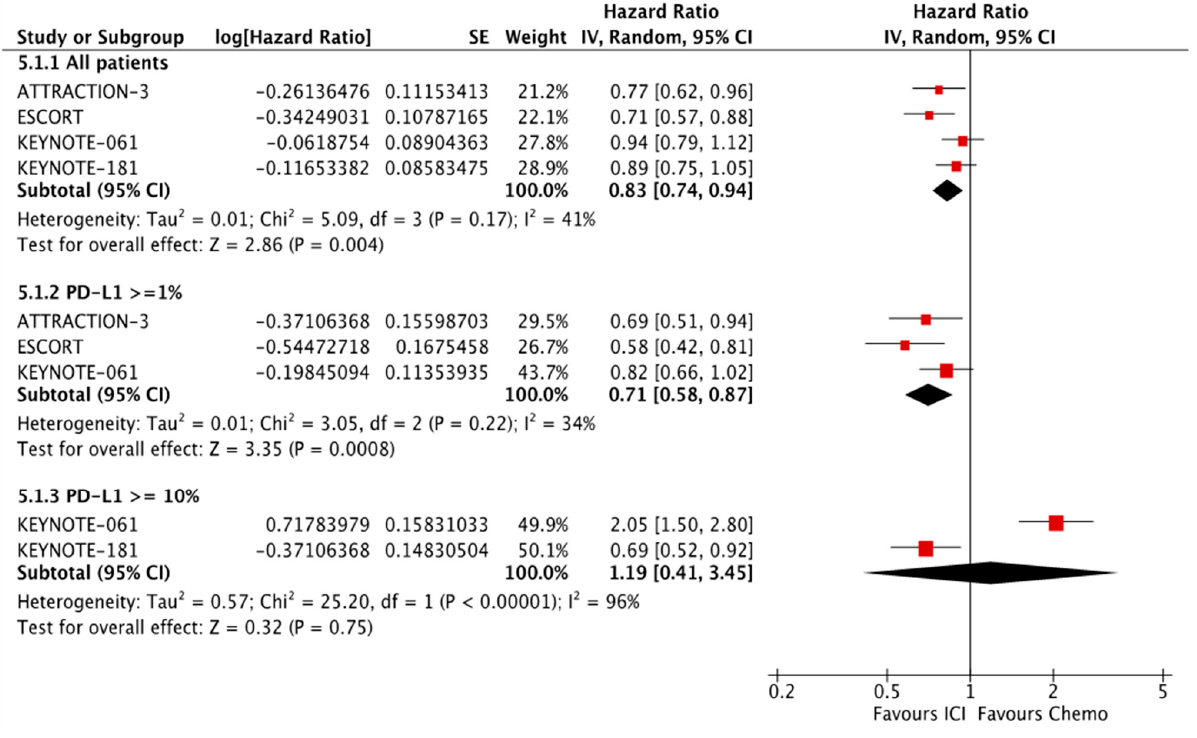
Figure 3. OS according to PD-L1 expression in the second-line setting.